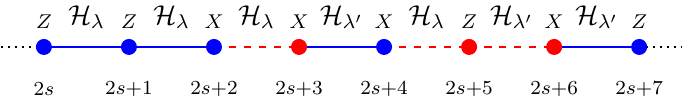
Figure 11 . A section of the dilute spin chain for the XZ sector, for a specific configuration of states. We have chosen the gauge group to the left of site 2 s to be the first one (depicted by a blue solid line). To make it easier to read off the relevant gauge group for each Hamiltonian, we have also coloured the first of each two sites on which the Hamiltonian acts the same as the region to the left of that site. Unlike the alternating chain depicted in (8), here the choice of which Hamiltonian acts on each pair of sites is not related to the even-odd nature of the site but rather to the number of Z and X fields that have been crossed until that